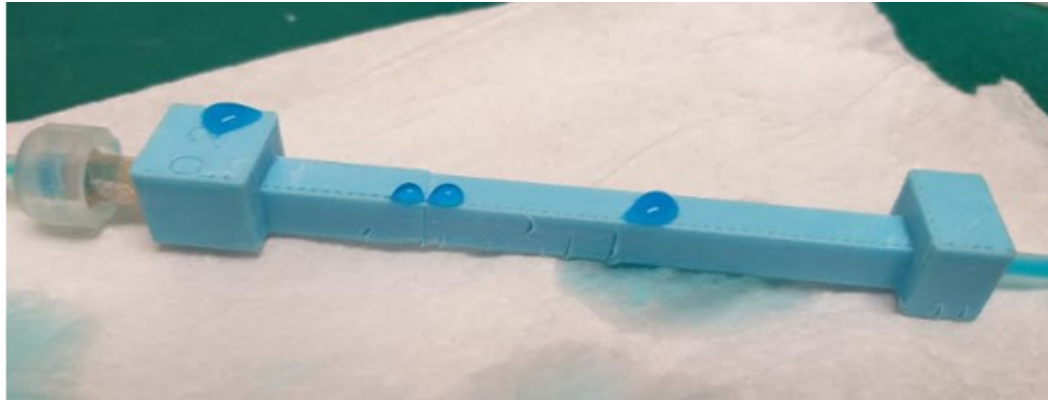
Figure 5. Leakage in the FDM printed linear